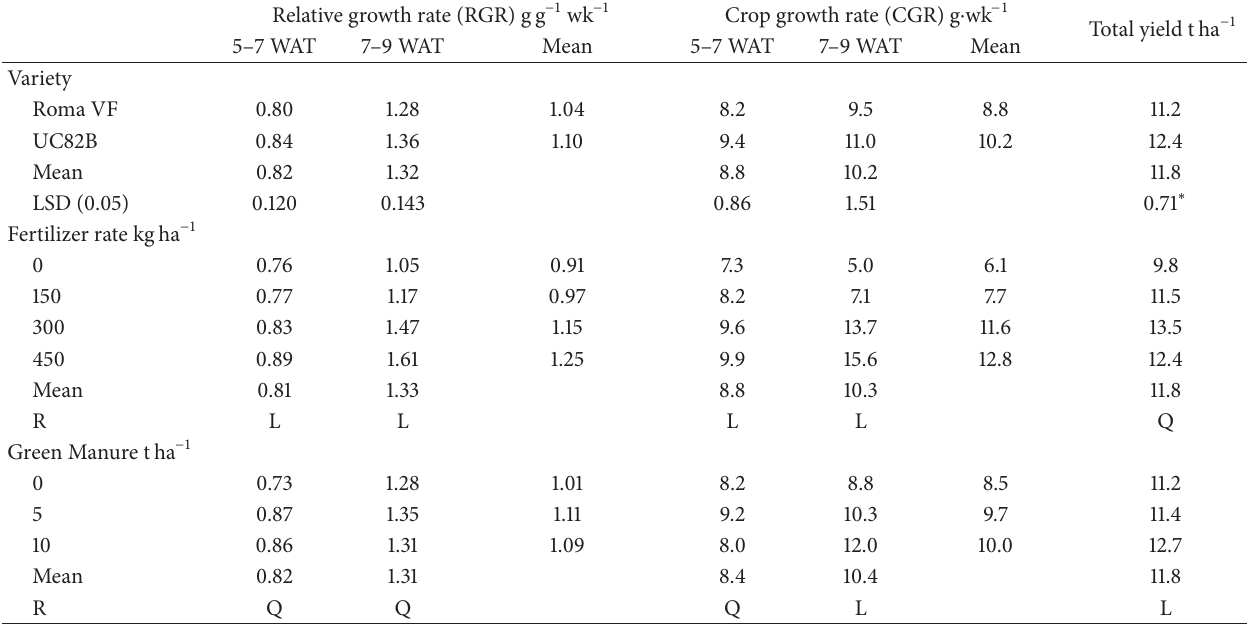
Table 4: Influence of NPK fertilizer and green manure rates on Relative growth rate, crop growth rate per plant, and yield of two tomato varieties in Samaru, 2010-2011 and 2011-2012 dry